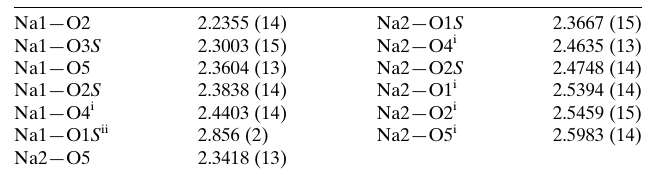
Table 1 Selected bond lengths (A˚ ).